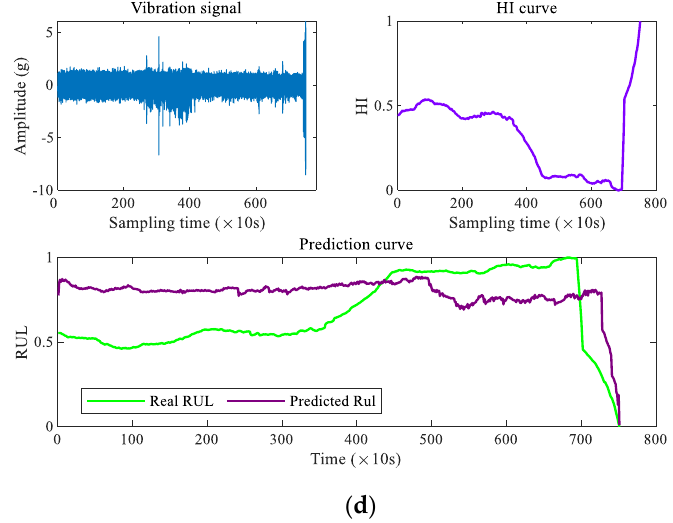
Figure 16. Life prediction effect of four bearings under working condition 2: ( a ) Bearing2_1, ( b ) Bearing2_2, ( c ) Bearing2_3 and ( d ) Bearing2_4.